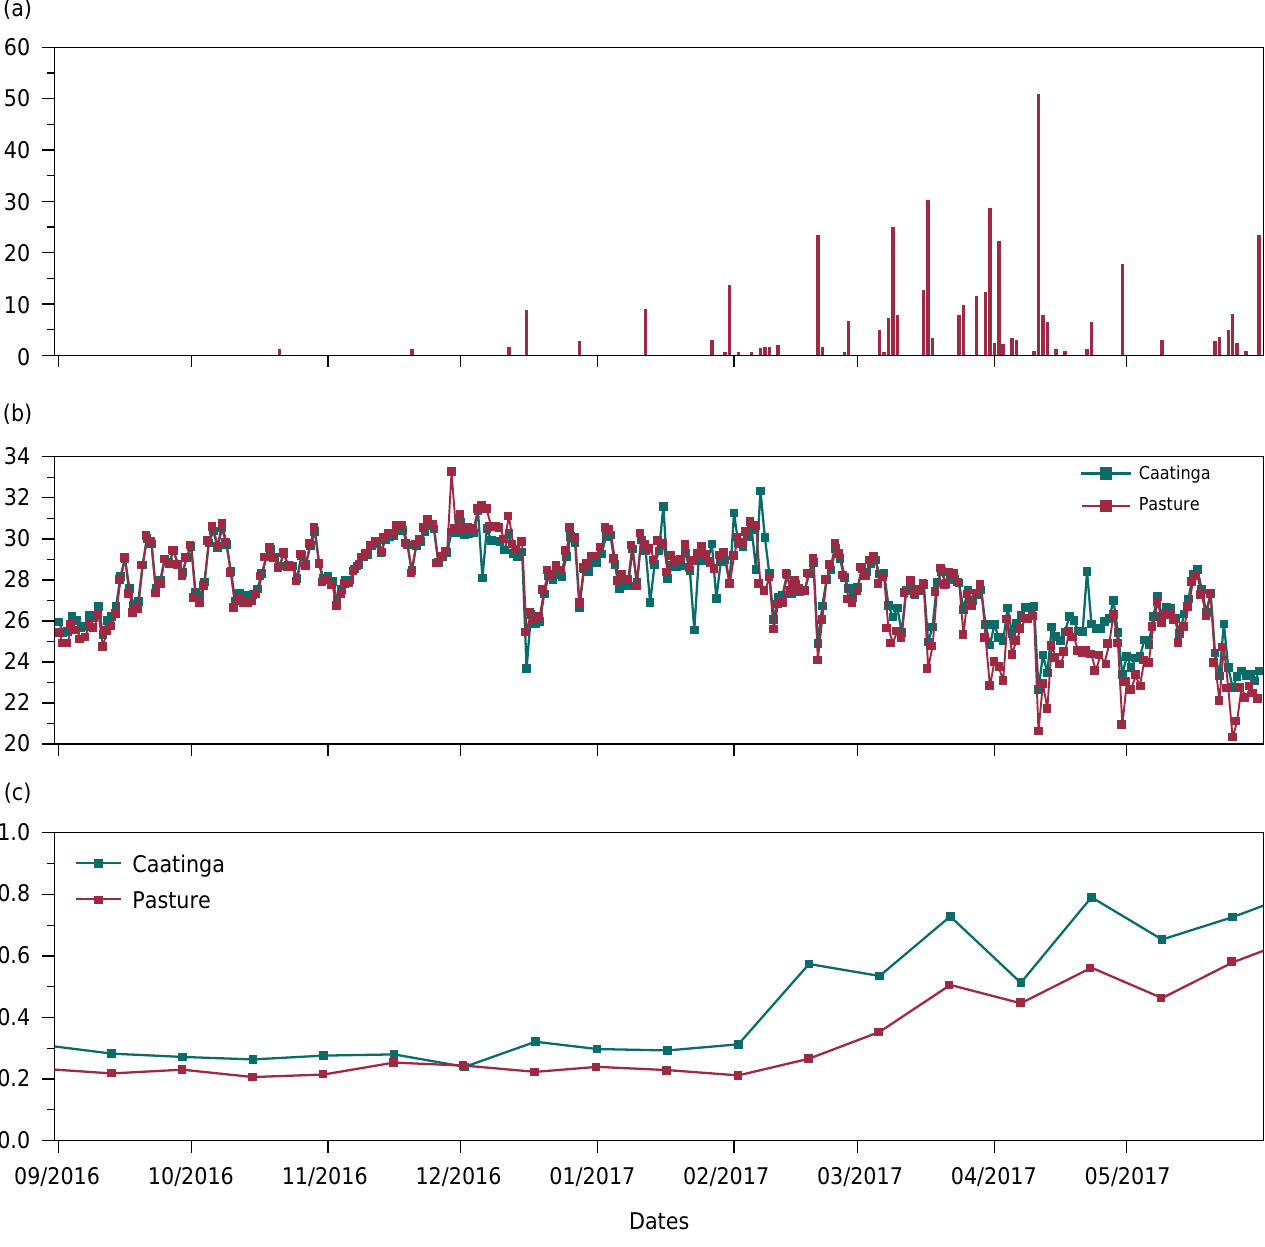
Figure 2. Temporal variation of precipitation, air temperature, and NDVI in Caatinga and degraded pasture